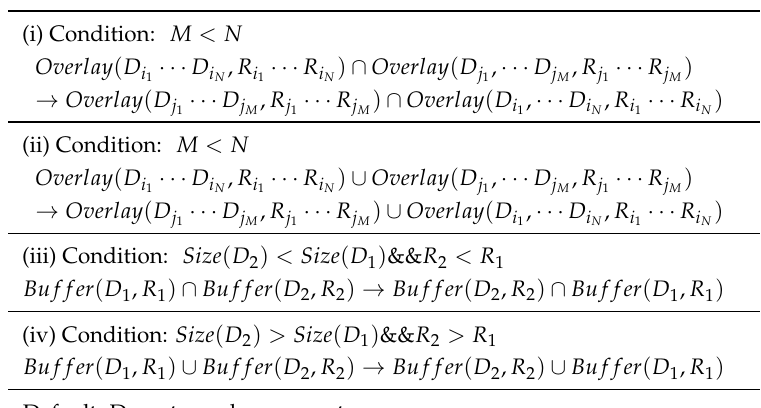
Table 6. Parameters Reordering of STBOO.